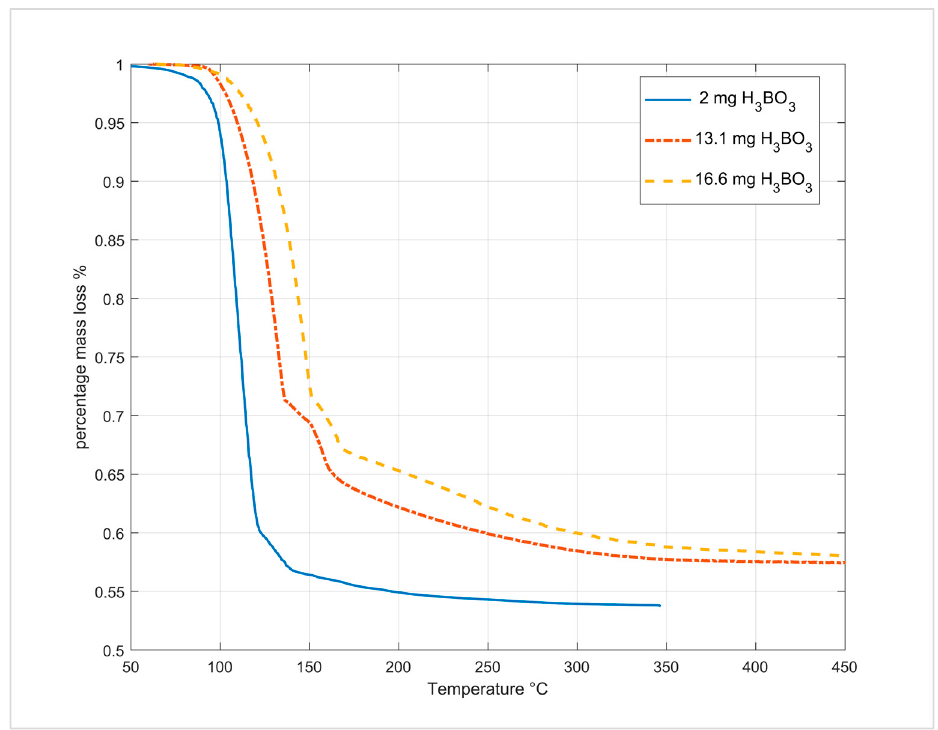
Figure 11. Dehydration (TG) of boric acid at a heating rate of 2 °C/min subject to different initial masses.